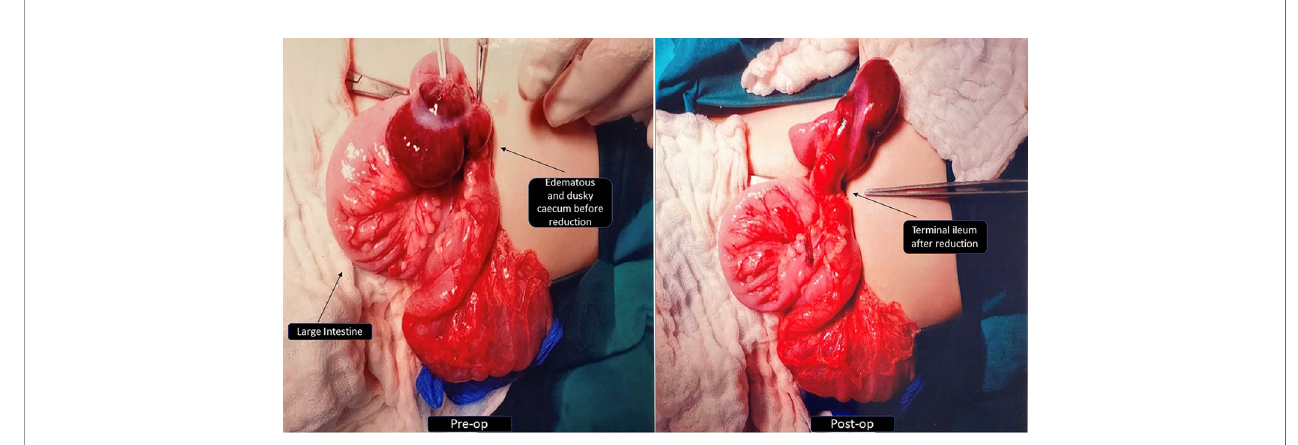
FIGURE 2 | Intra-operative photos before and after reduction of ileo-colic intussusception.